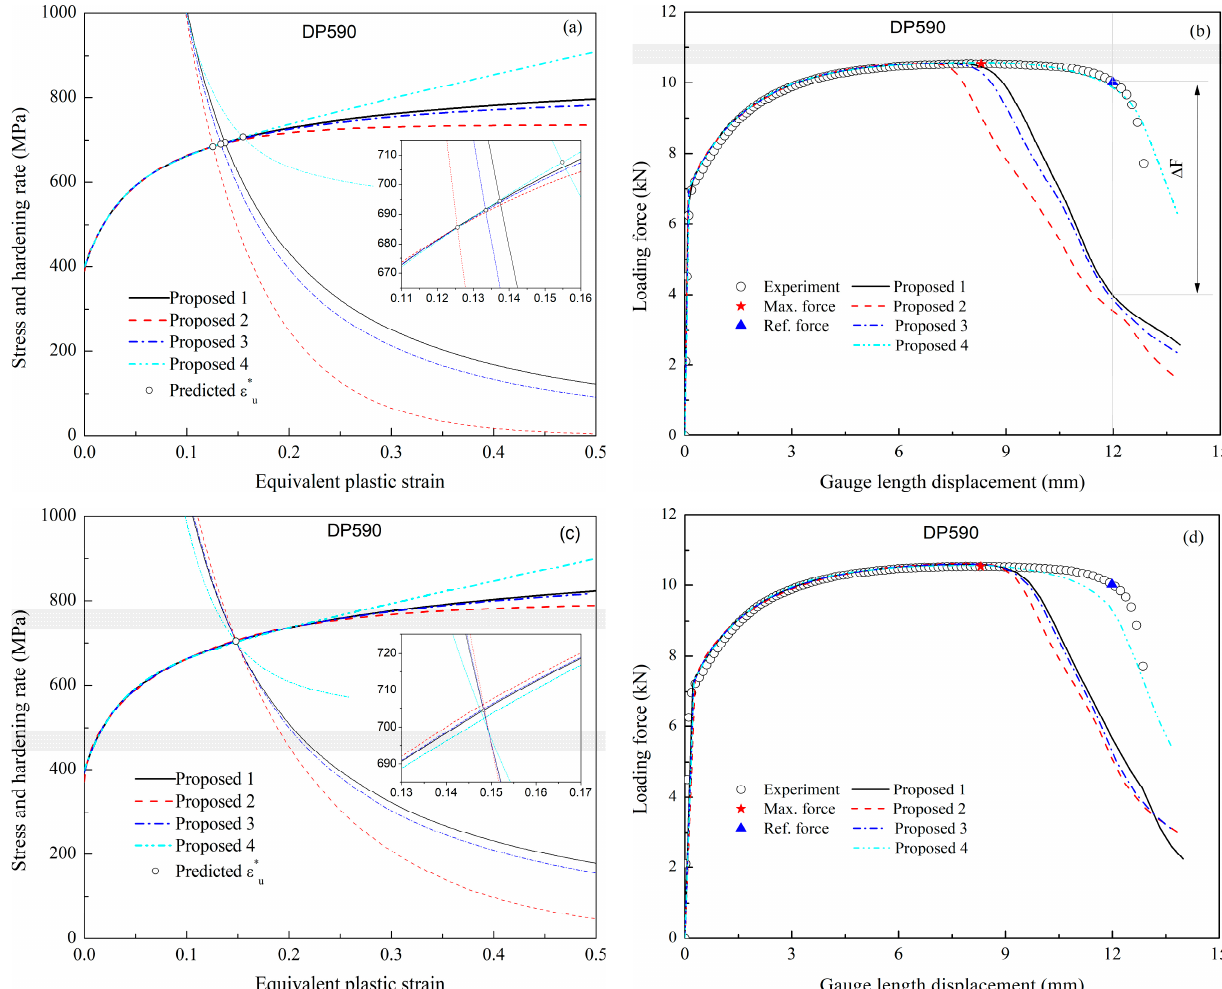
Figure 9. Comparison between the experimental and predicted tensile forces according to gauge length displacement of DP590 sheets. ( a ) Hardening laws identified by the common curve fitting method. ( b ) Tensile force predictions of the hardening laws reported in ( a ). ( c ) Hardening laws identified by the constrained curve fitting method. ( d ) Tensile force predictions of the hardening laws reported in ( c ).